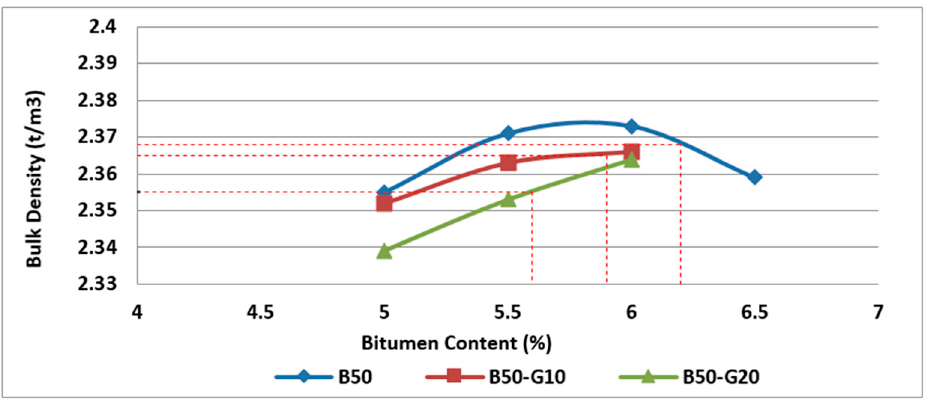
Figure 16. Effect of bitumen content and glass content on bulk density of Mix III containing 50% RCA without glass and Mix VI and Mix VII containing 50% RCA as coarse aggregate and glass as fine aggregate.